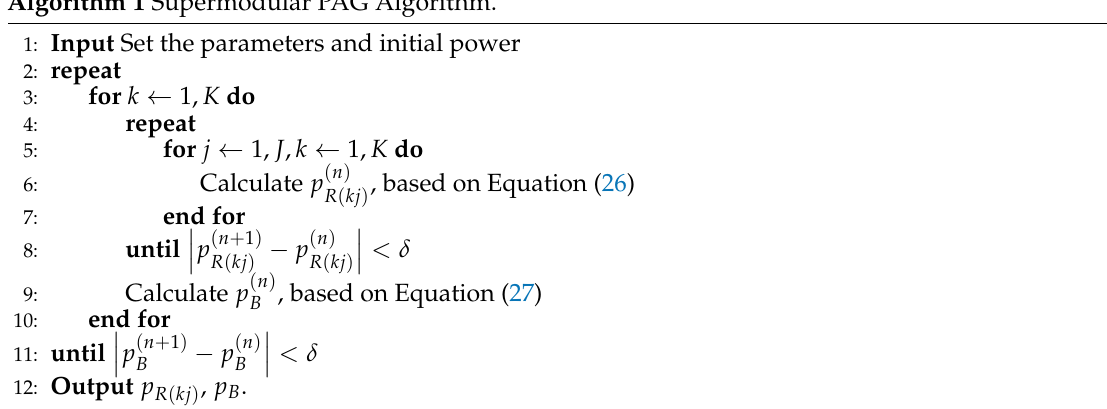
Algorithm 1 Supermodular PAG